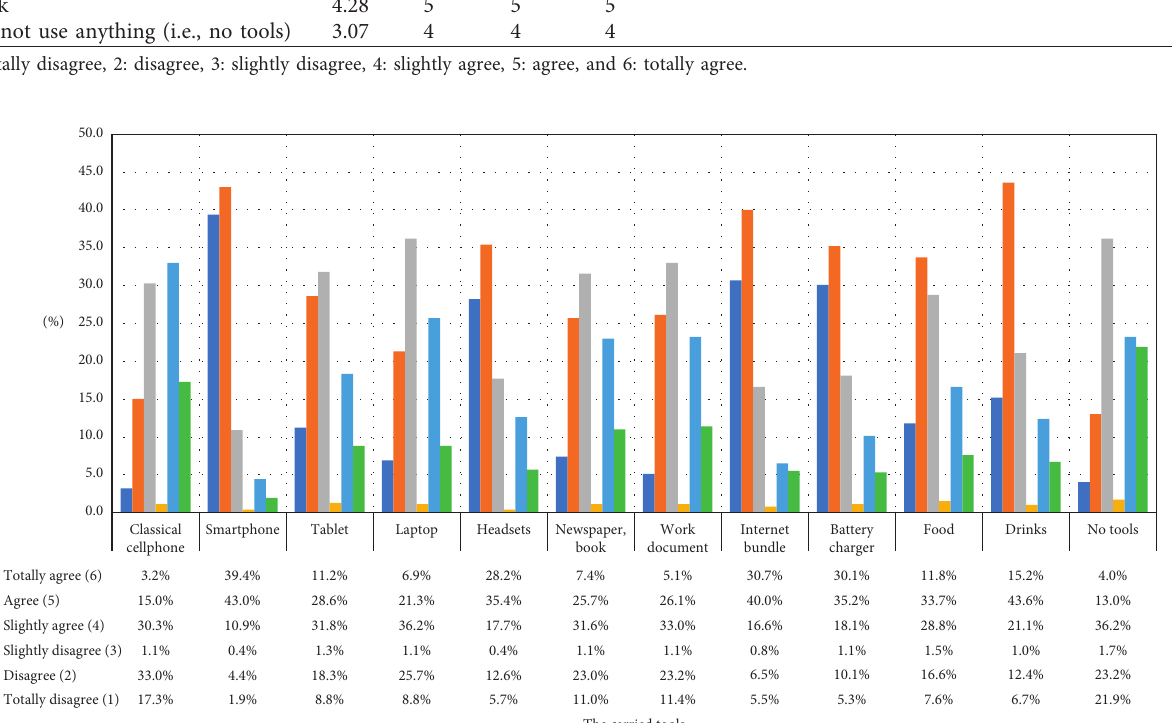
Table 3: The participants’ responses regarding the positive impact of various tools carried by travelers and onboard activities on trip time ∗ . Carried tools Tablet Laptop Headsets Newspaper, book Work document Internet bundle Battery charger Food Drink I do not use anything (i.e., no tools)